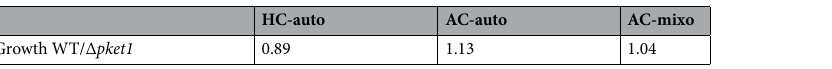
Table 1. Impact of simulated silencing pket1 on growth in various conditions. AC-auto, HC-auto and AC-mixo denotes the growth conditions, ambient CO 2 autotrophic, high CO 2 autotrophic and ambient CO 2 mixotrophic state, respectively.